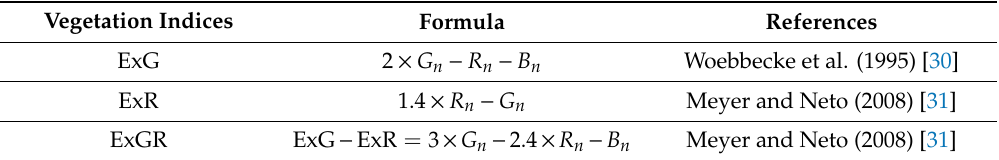
Table 3. Formulas of vegetation indices.